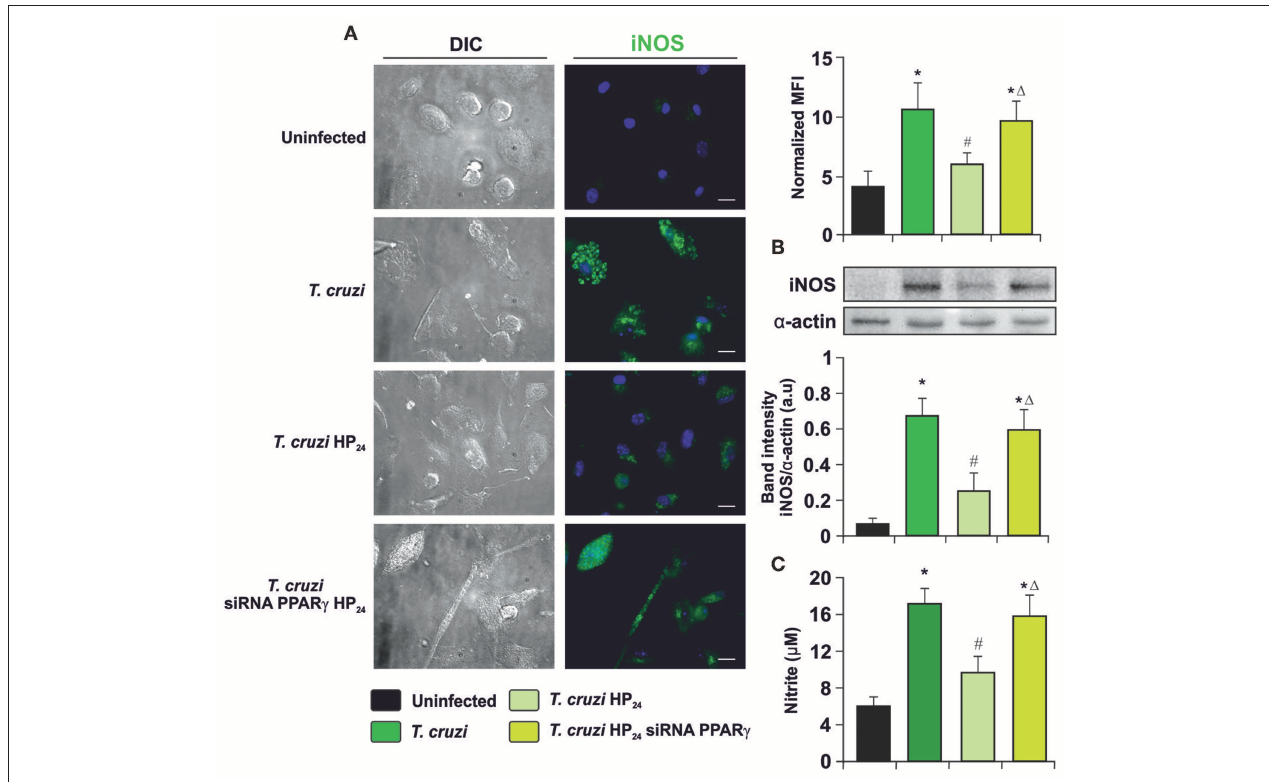
FIGURE 5 | Participation of PPAR γ in iNOS inhibition by HP 24 . (A) Peritoneal macrophages from T. cruzi -infected mice (9 dpi) were obtained. Cells were transfected with PPAR γ -siRNA during 72h. Transfected or non-transfected cells were treated with HP 24 (100 µ M) for 48h. iNOS expression was detected by immunofluorescence with a rabbit polyclonal anti-iNOS antibody and with a secondary goat anti-rabbit Alexa 488-labeled antibody. Cell nuclei were stained with DAPI. Mean fluorescence intensity (MFI) represents iNOS expression. Representative microphotographs are shown. Scale bar: 10 µ m. (B) Western blot analysis was carried out and iNOS expression was determined. Protein levels were normalized against α -actin. (C) NO release to culture supernatants was analyzed by the Griess method. Results are expressed as the mean of three independent experiments (six mice/group). * P < 0.05 vs. uninfected cells, # P < 0.05 vs. T. cruzi -infected cells. 1 P < 0.05 vs. T. cruzi -infected HP 24 -treated